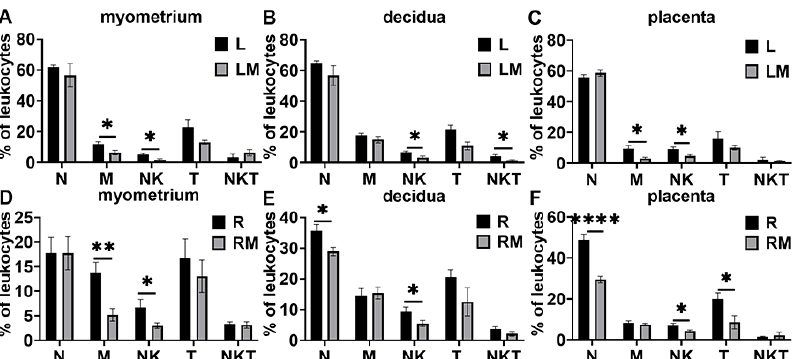
Figure 10. Effects of MCC950 treatment on leukocyte subsets in gestational tissues at the time of labor in LPS- and RU38486-induced preterm birth. Pregnant mice were administered LPS alone or LPS plus MCC950 at GD16.25 ( A – C ) or with RU38486 alone or RU38486 with MCC950 ( D – F ) at GD16. The mice were sacrificed after the onset of labor. Myometrium, decidua, and placentas were obtained for determination of neutrophils, macrophages, NK, T cells, and NKT cells by flow cytometry analysis. ( A , D ) Populations of leukocyte subsets in myometrium; ( B , E ) populations of leukocyte subsets in decidua; ( C , F ) populations of leukocyte subsets in placenta. Data are expressed as mean ± SEM. n = 6 in each group. * p < 0.05, ** p < 0.01, **** p < 0.0001. L, LPS; LM, LPS + MCC950; R, RU38486; RM, RU38486 + MCC950; N, neutrophils; M, macrophages.